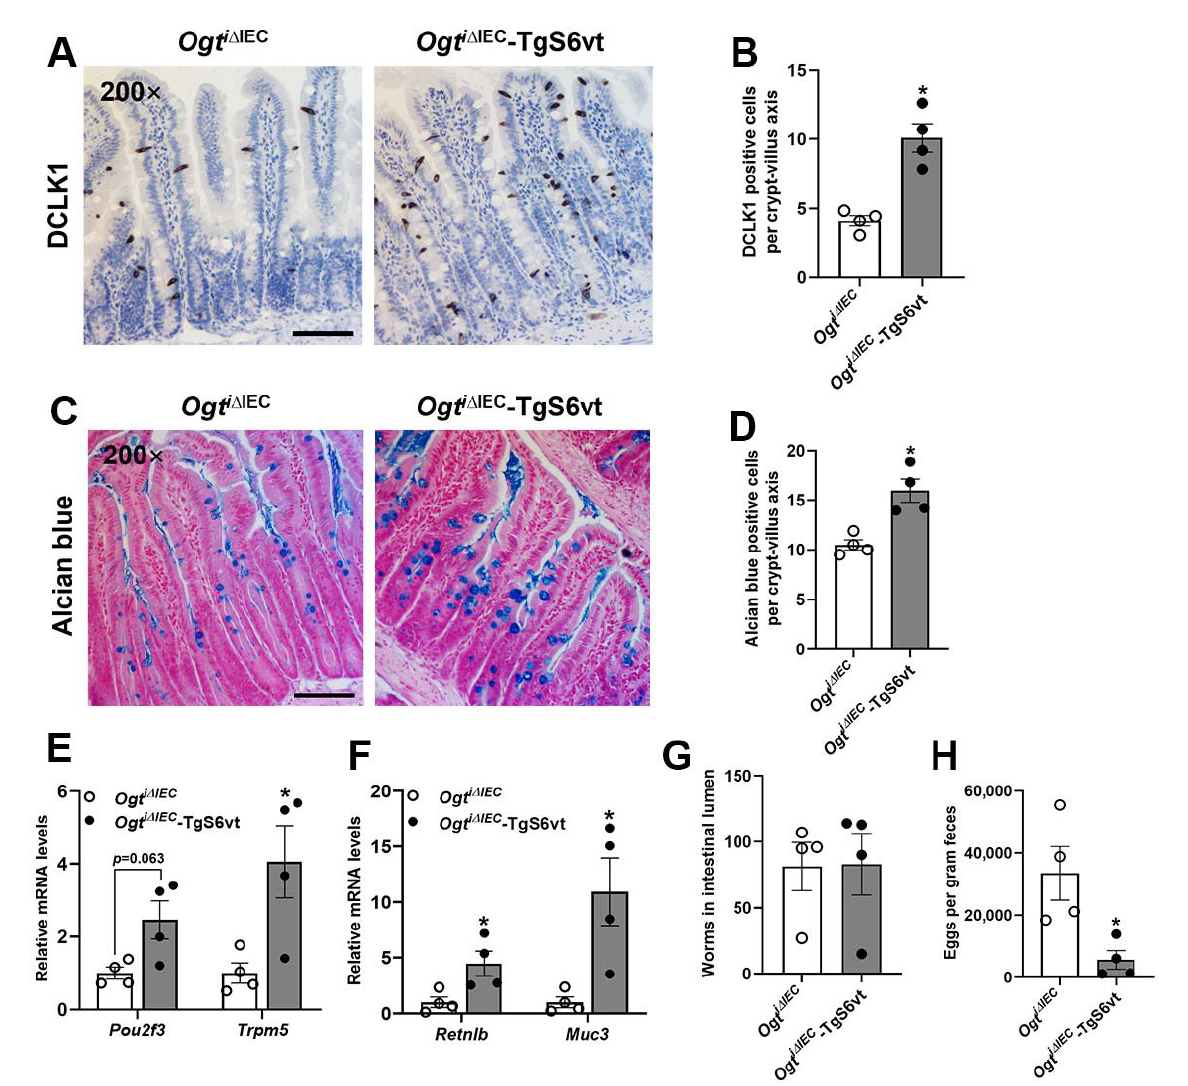
Figure 6. STAT6 overexpression rescues the defective anti ‐ helminth responses caused by epithelial Ogt ablation. The 8–10 ‐ week ‐ old male Ogt i ∆ IEC and Ogt i ∆ IEC ‐ TgS6vt mice were infected with H. poly and subjected to the following analyses on day 14 post ‐ infection. ( A ) Jejunal tuft cells were examined by DCLK1 IHC staining. ( B ) Quantification of tuft (DCLK1 positive) cells shown in ( A ) ( n = 4/group, 20 crypt ‐ villus units counted for each mouse). ( C ) Jejunal goblet cells were examined by Alcian blue staining. ( D ) Quantification of goblet (Alcian blue positive) cells shown in ( C ) ( n = 4/group, 30 crypt ‐ villus units counted for each mouse). ( E , F ) qPCR analysis of tuft ( E ) and goblet ( F ) cell markers expression in the jejunal IECs ( n = 4/group). ( G , H ) Analysis of parasite burden by quantification of adult worms in intestinal lumen ( G ) and eggs in feces ( H ) ( n = 4/group). Data are presented as mean ± SEM. * p < 0.05. Scale bars, 100 μ m.